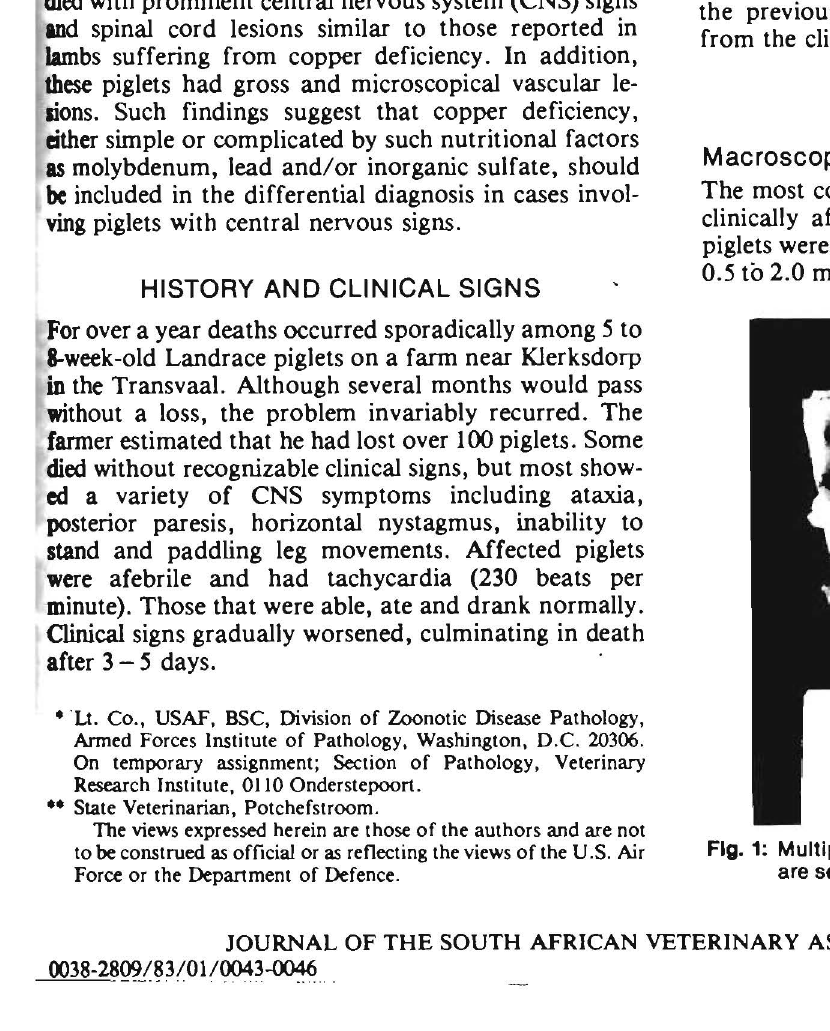
Fig. 1: Multiple small haemorrhaglc·appearing lesions that are seen from the Intimal surface of the thoracic